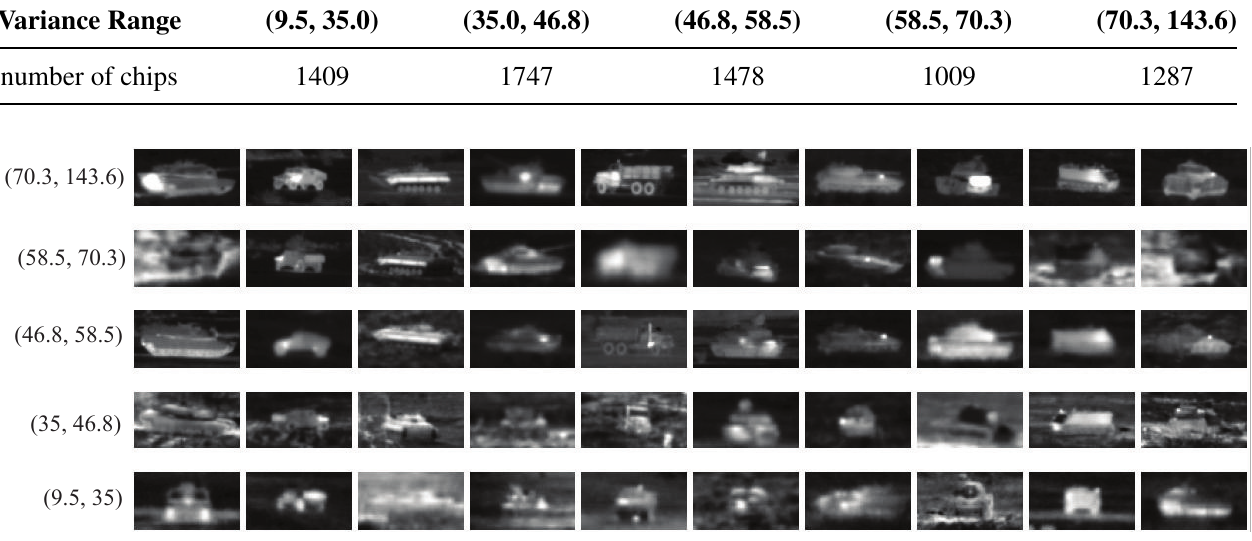
Figure 11. Examples of targets in each variance range. Table 12. The recognition rate in each range averaged by 10 random